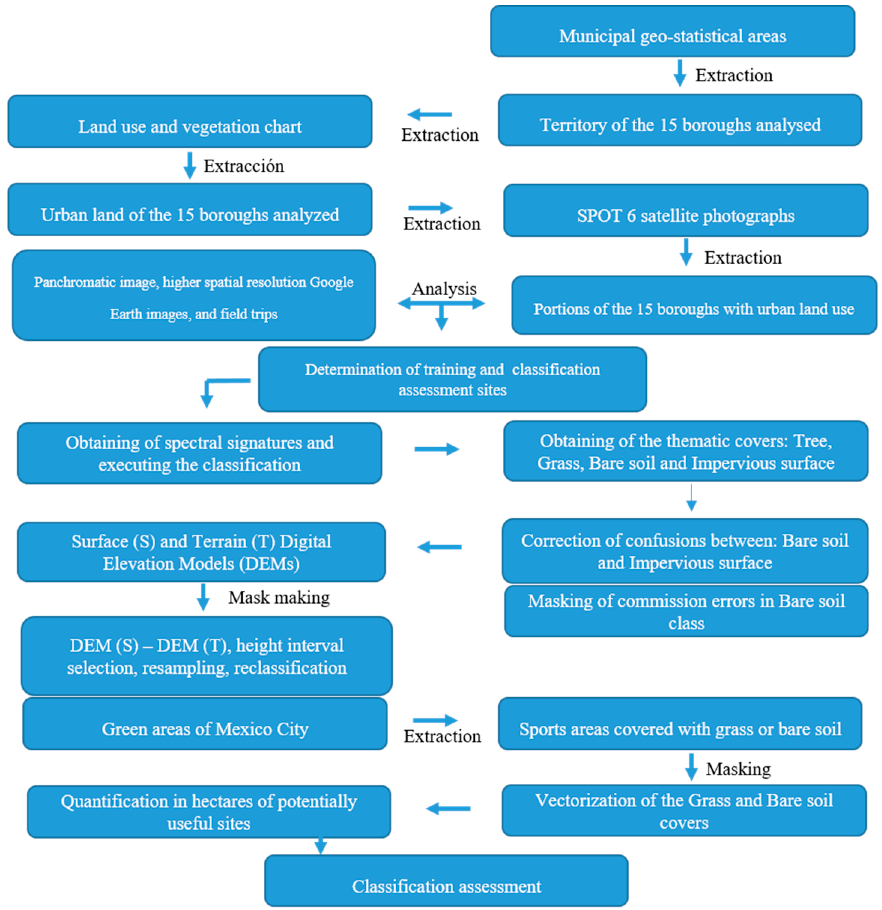
Figure 3. Flowchart for the identification of potential planting sites.